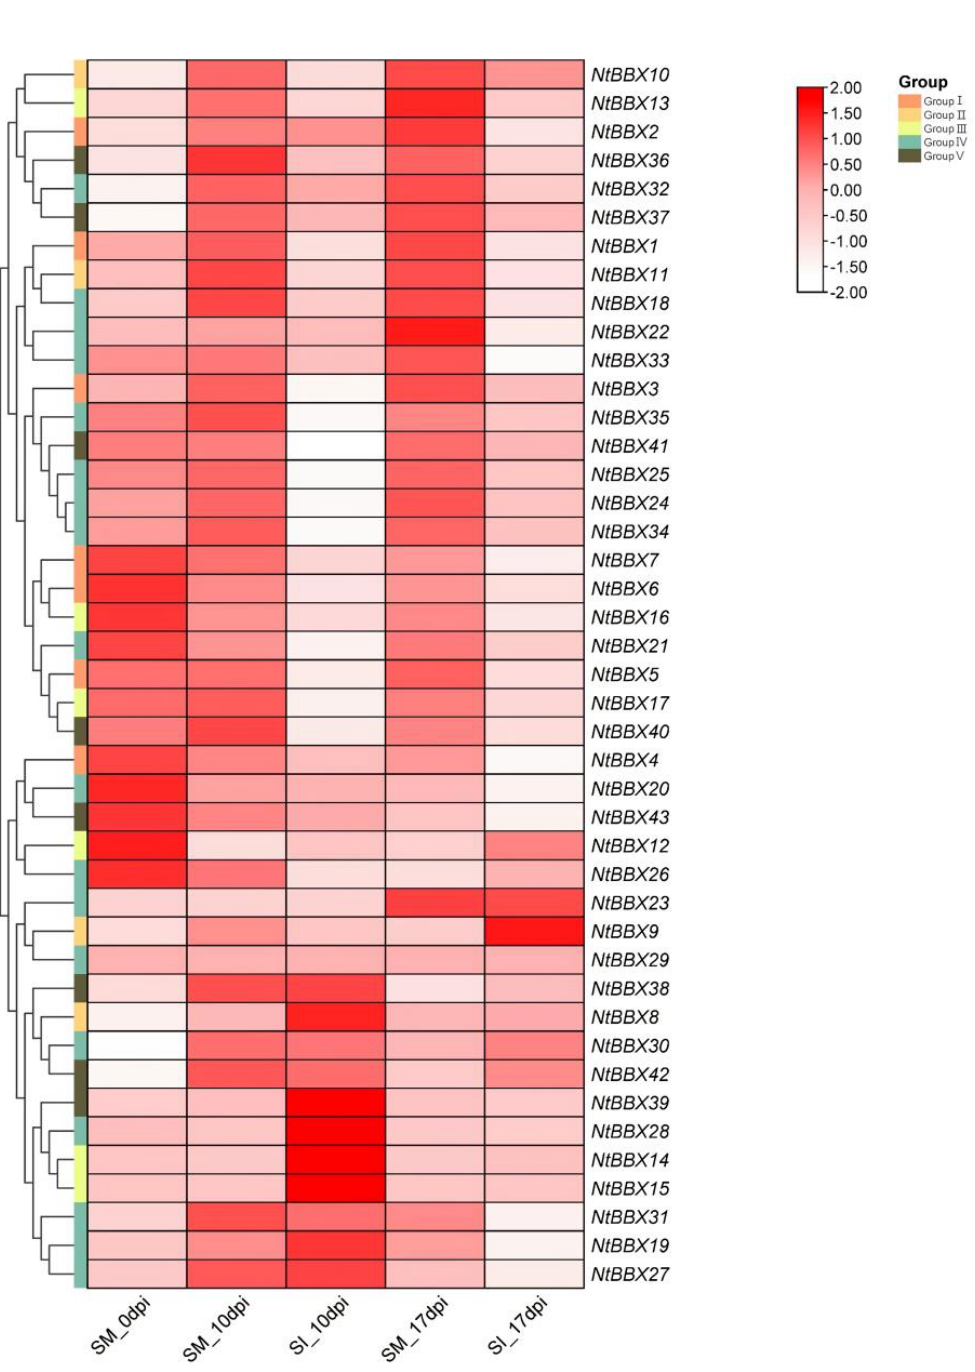
Figure 7. Expression patterns of NtBBX genes under biotic stress. SI, no infection. SM, infection with R. solanacearum . Dpi, days after infection. Subgroups I–V are represented by different colored boxes.